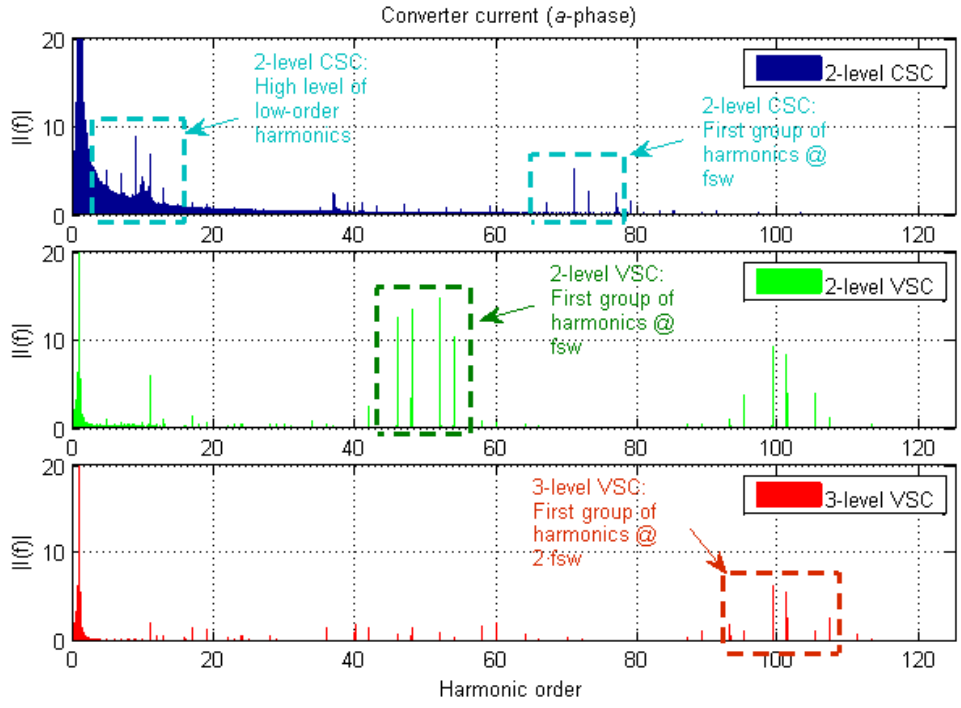
Figure 17. FFT analysis of the converter current ( a -phase) of each